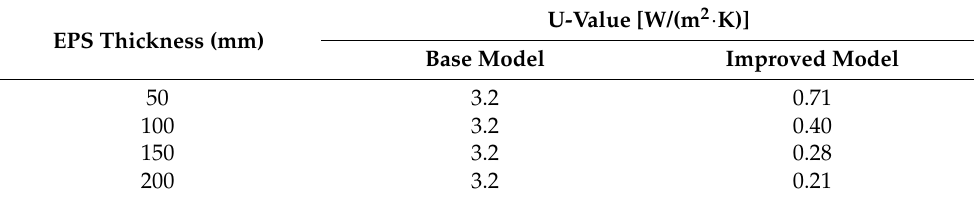
Table 8. External wall insulation fabricated of expanded polystyrene (EPS) and their thermal properties.